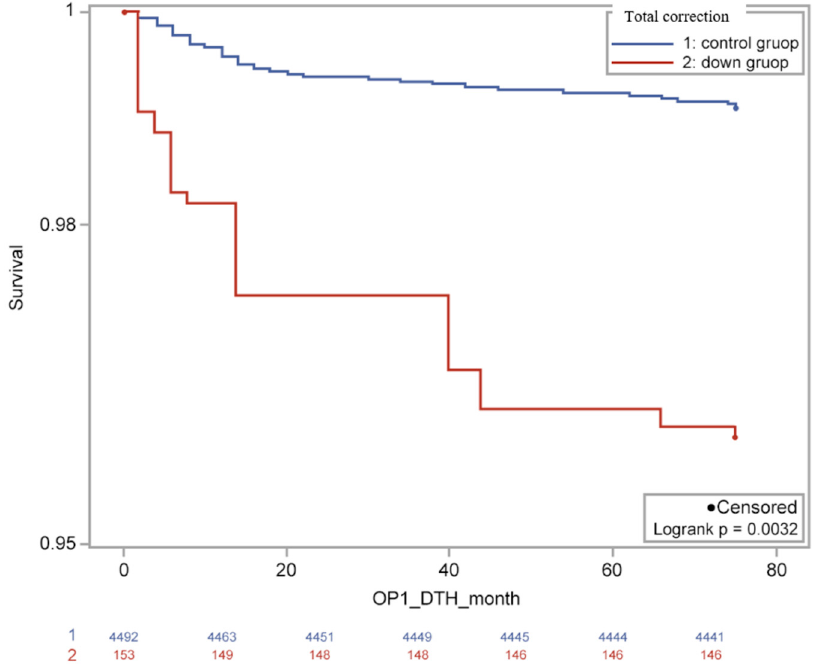
Figure 2. Kaplan–Meier survival curve in the Down syndrome and control subjects who underwent total correction. The cumulative survival rate in the control group was significantly higher than in the Down syndrome group (HR = 4.3, 95% CI: 1.9–9.9). HR, hazard ratio; CI, confidence interval.